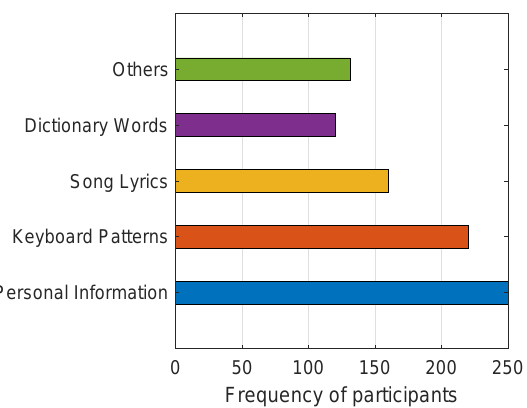
Figure 7. Frequently used in surveyed